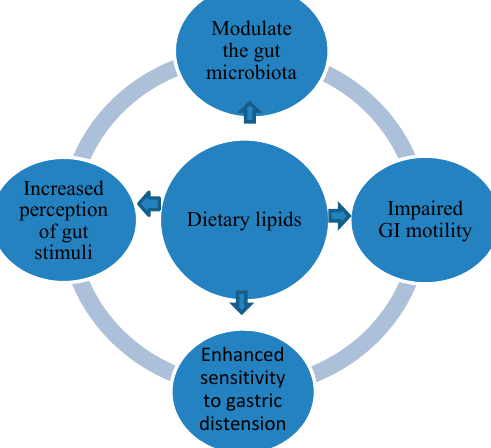
Figure 3. Mechanisms linking dietary lipids and GI symptoms.